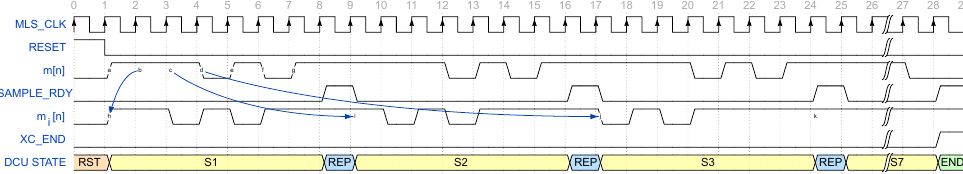
Figure 8. Waveform diagram of the DCU signals by considering an L equal to 3 ( N equal to 7). As the global RESET signal is asserted (0th cycle), LFSR1 and LFSR2 load the STATE [ 0 ] and STATE [ 1 ] words, respectively. LFSR3 loads the STATE [ 1 ] word since its LOAD input, i.e., the output of the OR port is set to 1 and the “1” input of the multiplexer is selected. During the first complete sequence (S1 state from the first to the seventh cycles), LFSR1 and LFSR3 produce exactly the same MLS sequence but the starting index of LFSR3 is incremented by 1 with respect to LFSR1. As LFSR1 and LFSR3 end their sequences (eighth cycle), their CNT outputs go high for a clock cycle (see SAMPLE_RDY at the eighth cycle). This output signals the end of the current sequence. During this clock cycle, the states of m and m i are repeated. Since the SAMPLE_RDY output serves as the clock input for LFSR2 at its positive edge, the state of LFSR2 accomplishes a step forward and becomes S2. Since the “0” input of the multiplexer is selected (the RESET signal is 0) and since the LOAD input of LFSR3 is 1, the LFSR3 initial state for the new sequence is incremented to S2. As a result, the starting index of the m i sequence will be incremented at every m completion (see the 9th and 17th cycles). The algorithm ends after seven repetitions during which the whole 7 × 7 C circulant matrix has been serially provided at the m i output. The end of the operation is signaled through the CNT output of LFSR2 (see XC_END at the 29th cycle).